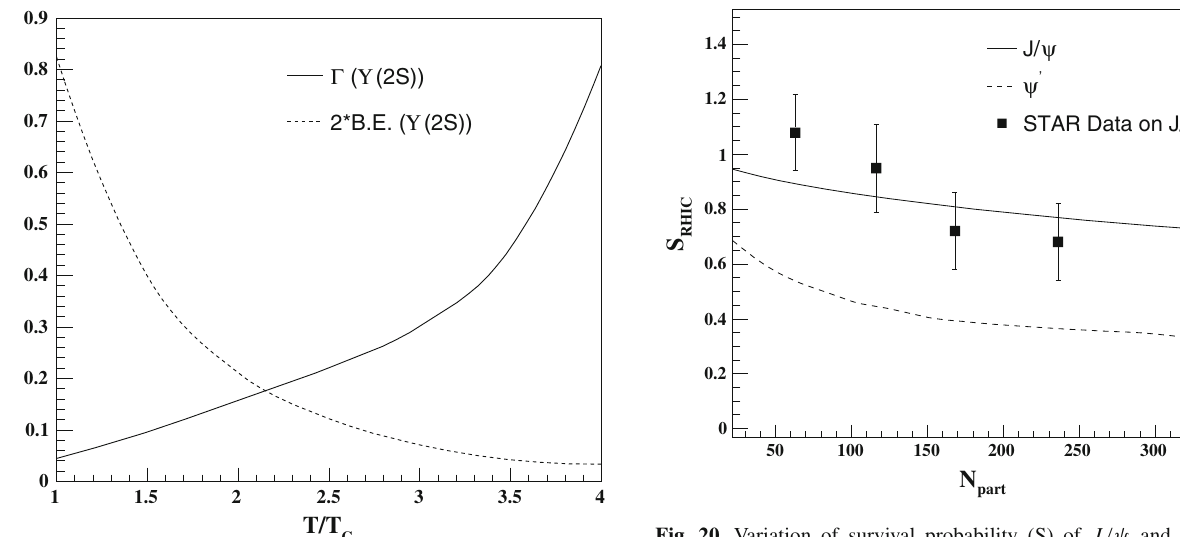
√ s NN = 200 GeV. Experi-